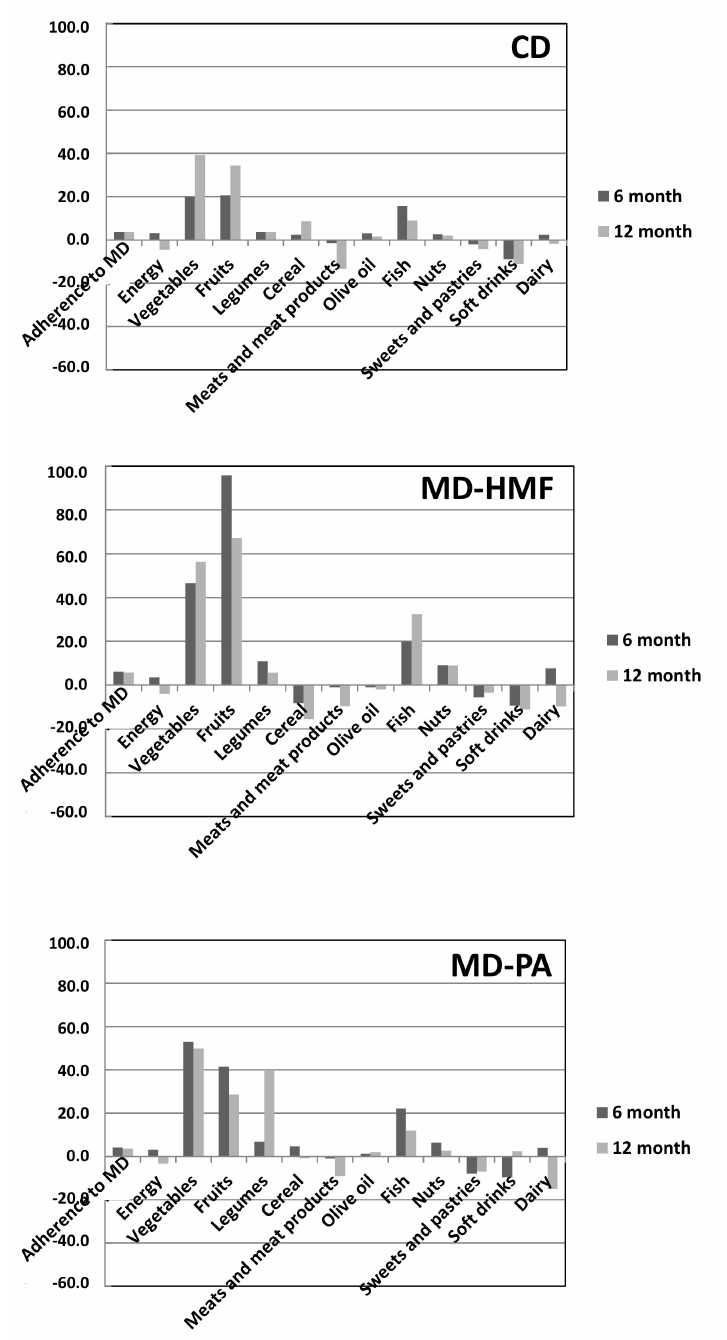
Figure 3. Changes in adherence to MedDiet, energy and nutrients intake at 6 and 12 months follow-up versus baseline. CD: Conventional Diet; MD–HMF: Mediterranean diet–high meal frequency; MD– PA: Mediterranean Diet–physical activity (control group). Energy was represented as kcal × 10 − 2 . Meat and dairy intake were represented as g/d per 100